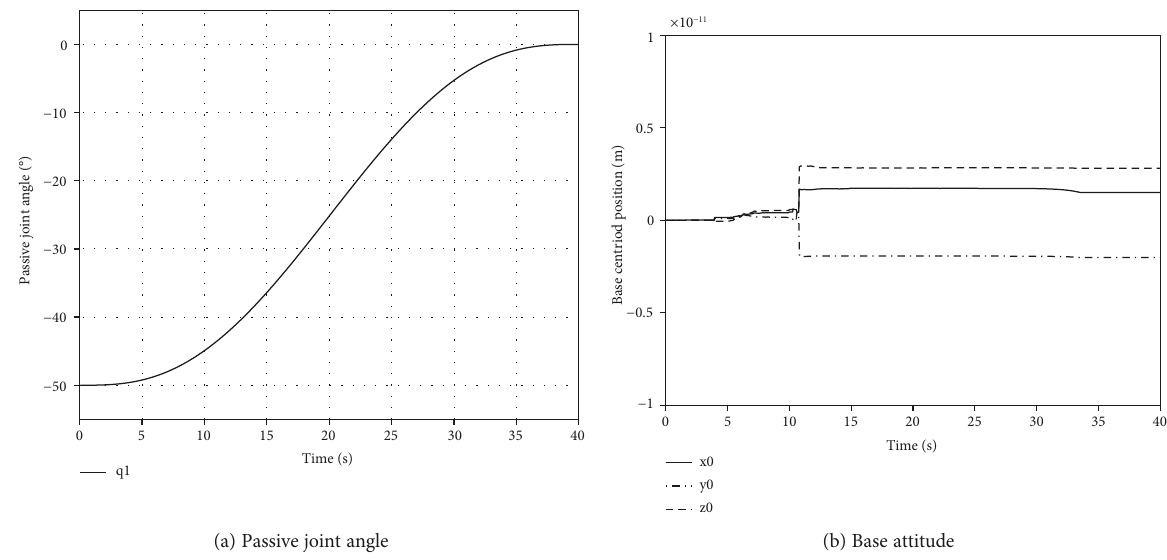
Figure 10: The variations of passive joint angle and base attitude with execution of the combination task. Table 3: Kinematic and dynamic coupling indexes.